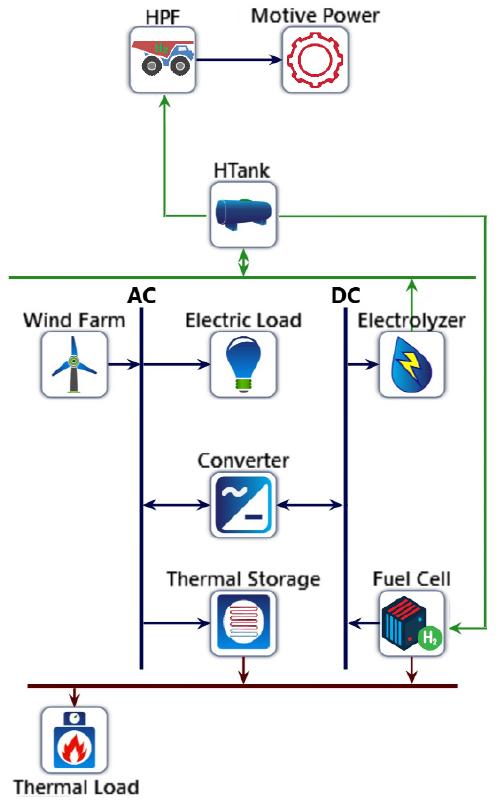
Figure 5. All-renewable system with hydrogen-powered fleet (HPF) and fc storage configuration.